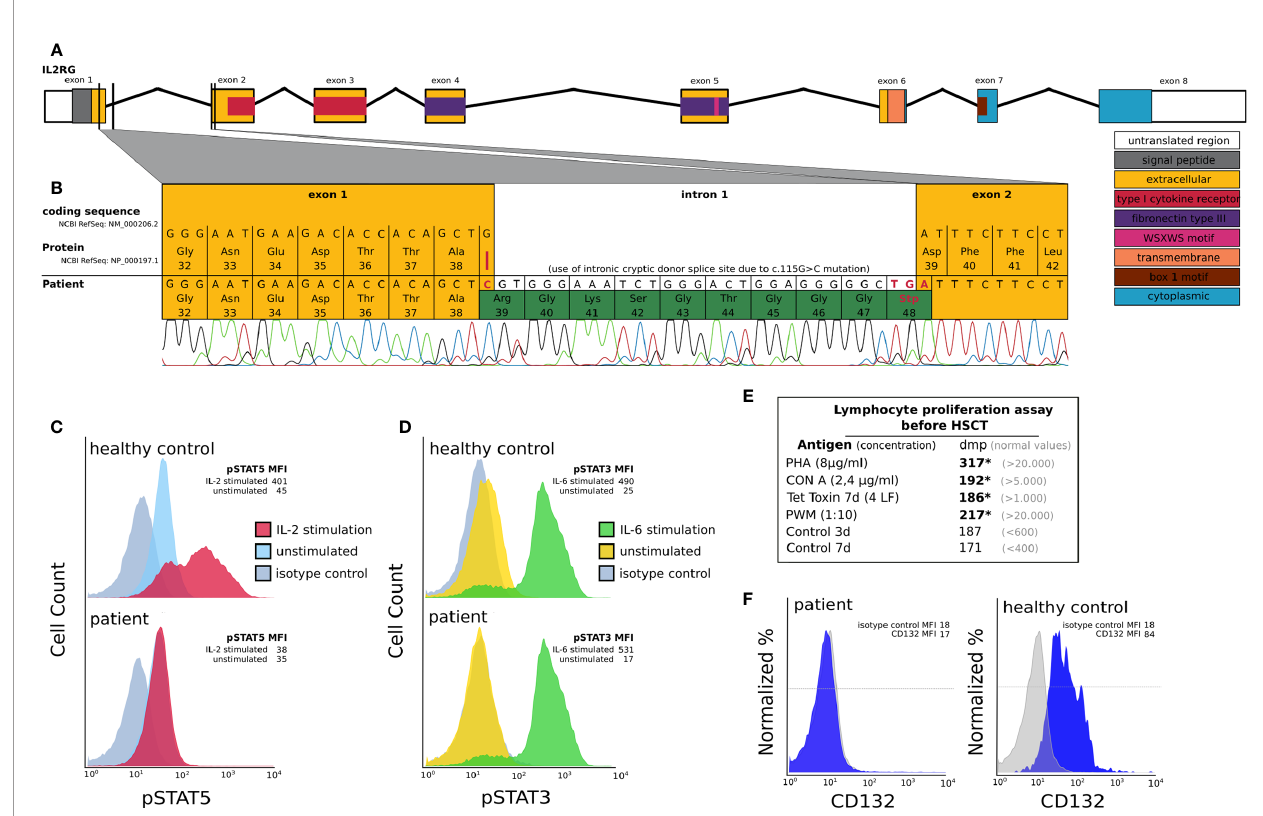
FIGURE 1 | Molecular and functional characterization of a novel IL2RG mutation prior to HSCT: (A) Schematic depiction of the IL2RG gene including introns, exons, splice sites and protein domains. (B) IL2RG mutation analysis of cDNA derived from EBV transfected lymphoblastoid cell lines of the patient (day -8 pre HSCT). The patient ’ s IL2RG donor splice site mutation c.115G>C (red line) results in a cryptic donor splice site located at c.115+29 in intron 1. This mutation leads to an insertion of 28 additional nucleotides resulting in a frameshift and premature stop codon at position 48 (highlighted green). (C, D) IL-2RG function analysis in an EBV transfected lymphoblastoid cell line of the patient using fl ow cytometry. We could demonstrate a reduction of pSTAT5 expression following IL-2 stimulation (red curve, C), which is known to be IL2RG dependent, in the patient ’ s cells compared to those of a healthy control. In C the FACS histograms depicting pSTAT5 expression in IL2-stimulated and unstimulated patient cells overlap. IL2RG independent pSTAT3 expression following IL-6 stimulation (green curve, D) was comparable in patient and healthy control cells. Unstimulated cells are shown in blue (for pSTAT5) and yellow (for pSTAT3). The grey curves depict an isotype control. In D the FACS histograms depicting pSTAT3 expression in unstimulated healthy control cells and the isotype control overlap. The mean fl uorescent intensities (MFI) are shown for the patient and the healthy control cells (HC). (E) Lymphocyte proliferation assay prior to HSCT. We can detect severely reduced (*) lymphocyte proliferation following stimulation with PHA, CON A, Tetanus toxin and PWM (dmp = disintegrations per minute of 3H-thymidine incorporation). (F) IL2RG (CD132) expression on B cells using fl ow cytometry. The mean fl uorescent intensities (MFI) are shown for the isotype control and